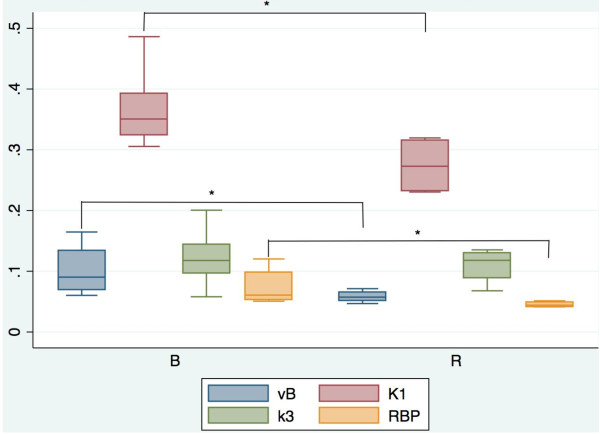
Box-Whiskers plots of median values for both tracers for vB, K1, k3 and RBP. *P values < 0.05). B, 68Ga-BZH3; R, 68Ga-RGD4.